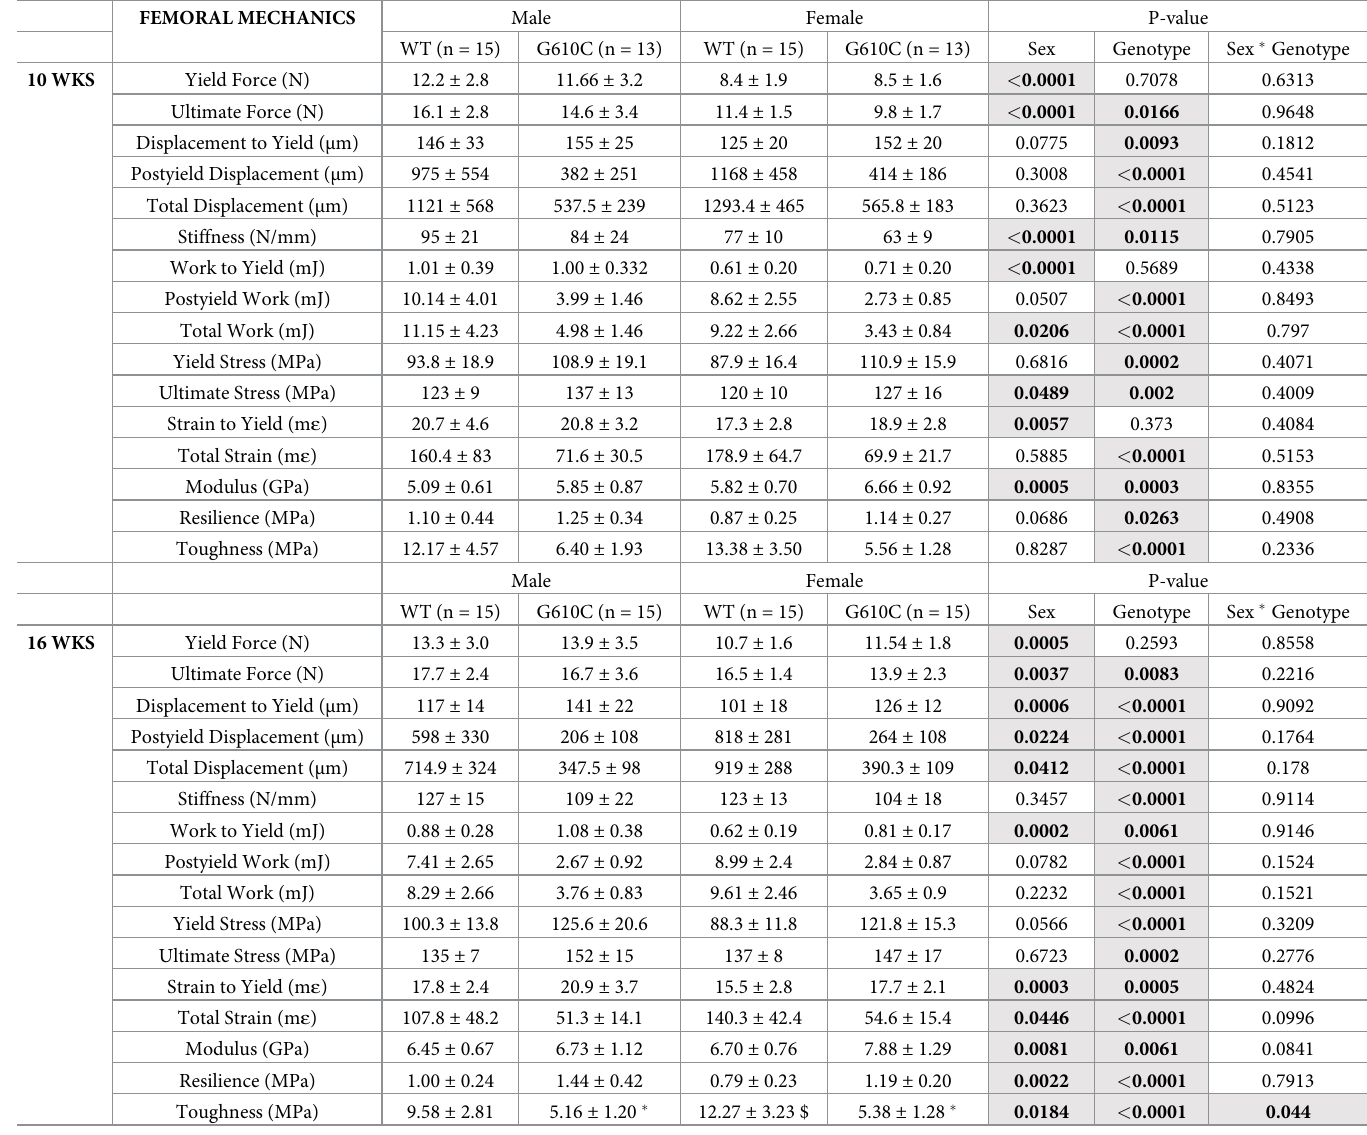
Table 7. Femur mechanical properties at 10 and 16 weeks, with p-values from 2-way ANOVA. FEMORAL